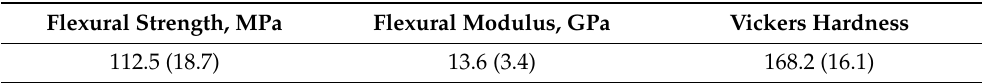
Table 2. Mechanical properties of the SiO 2 /pHEMA-based composite given as mean values (with standard